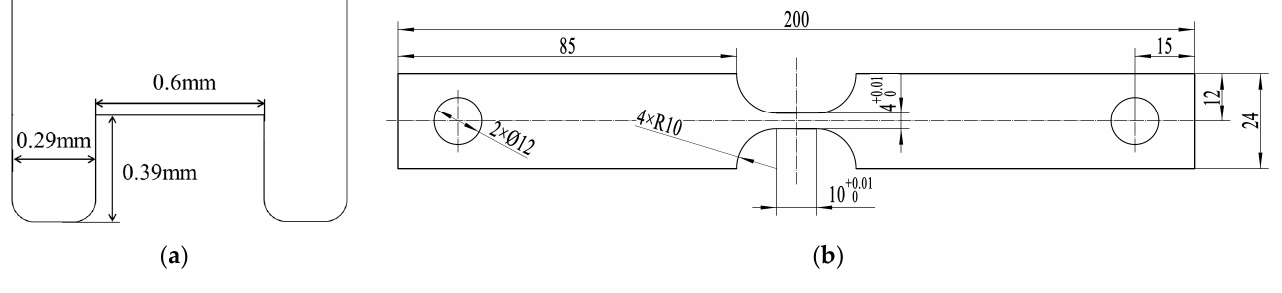
Figure 2. Die and specimen design of micro ‐ filling experiment (Unit: mm): ( a ) Filling die; ( b ) Specimen.